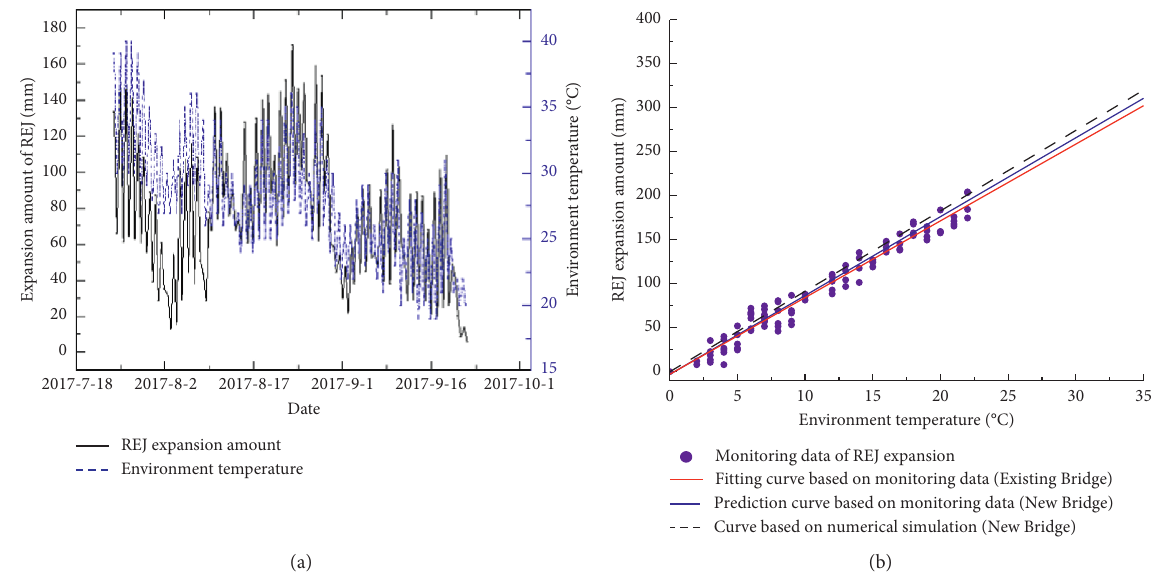
Figure 15: Relationship between REJ expansion and environment temperature. (a) REJ expansion during different periods. (b) Fitting